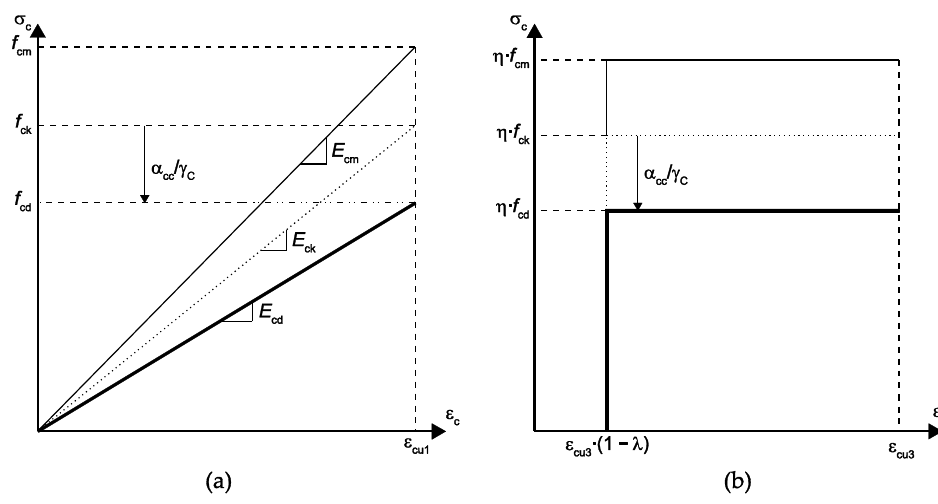
Figure 3. σ – ε diagram for the concrete: ( a ) linear elastic-strain curve and ( b ) stress block. Figure 3. σ–ε diagram for the concrete. Table 4. Overview of the model uncertainty—statistical description of the variables [9].